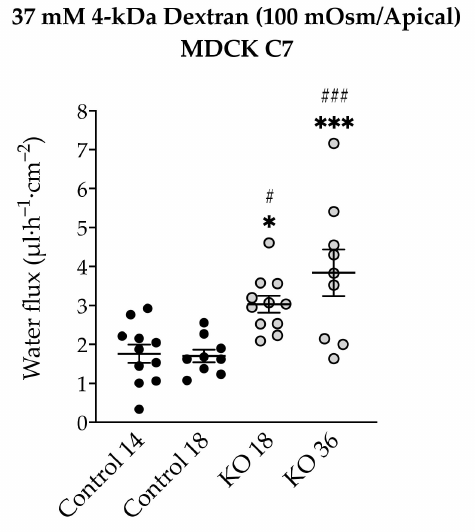
Figure 8. Water flux in angulin-1 knockout MDCK C7 cells induced by a gradient of 37 mM 4-kDa dextran on the apical side ( n = 10–11). The transepithelial water transport increased in both angulin-1 knockout clones. (* p ≤ 0.05, *** p ≤ 0.001 with regard to control 14 and # p ≤ 0.05, ### p ≤ 0.001 with regard to control 18).